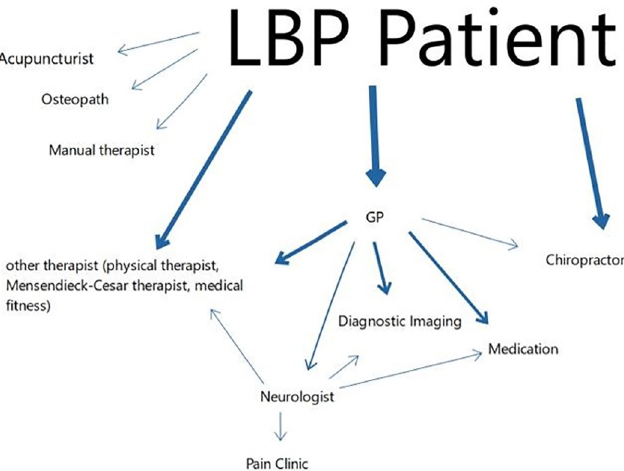
Fig 1. The pathways the participants of this study took up to the interviews. The thickness of the arrows indicates the proportion of participants that followed this pathway.